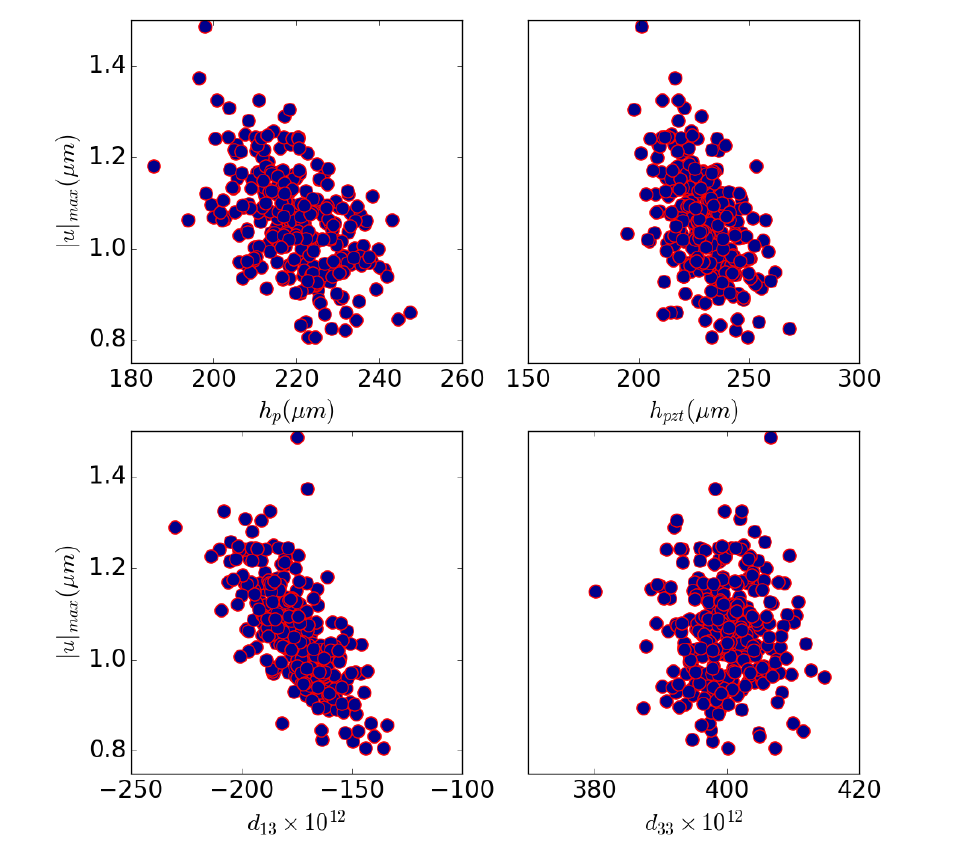
Figure 12. Scatter plot of maximum deflection at the center of the disc with geometrical and material property parameters using the Latin hypercube sampling